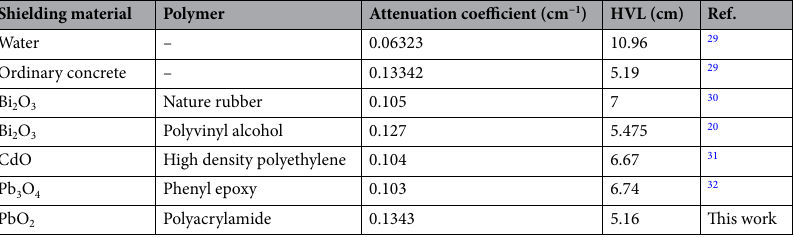
Table 1. HVL value of radiation shielding materials at 1.25 meV.